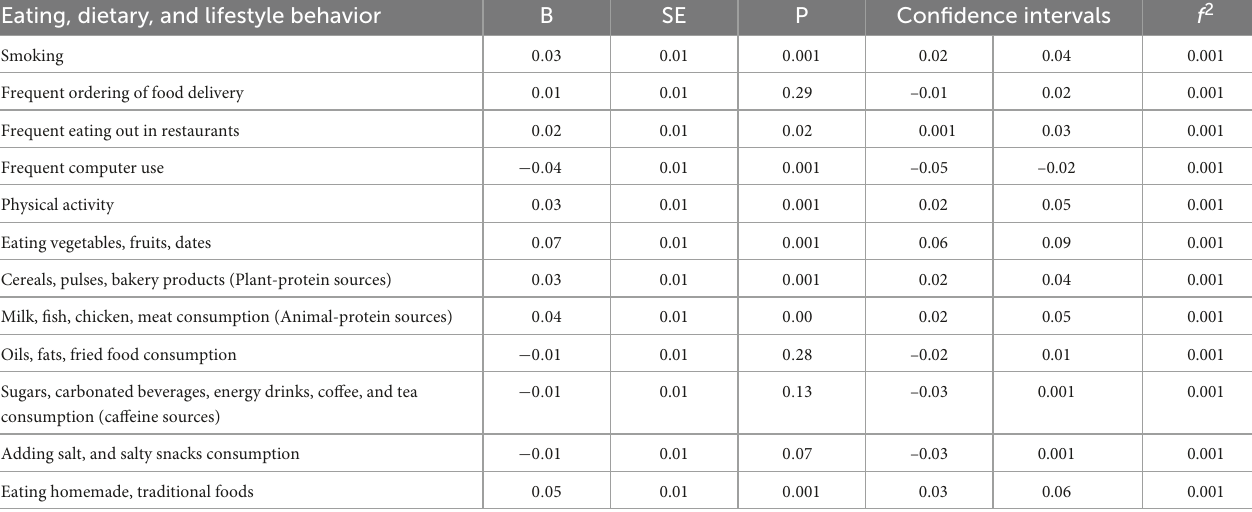
TABLE 6 Associations between dietary and lifestyle behaviors and sleep disturbance ( N = 24,541). Eating, dietary, and lifestyle behavior